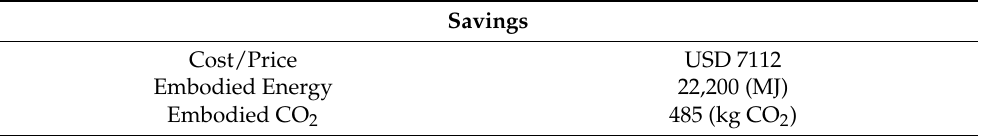
Figure 4. ( a ) Standard solid table design having a mass of 1370 kg. ( b ) Lightweight table design having a mass of 687 kg. Table 8. Cost/price, embodied energy, and embodied CO 2 , savings from lightweighting the table.